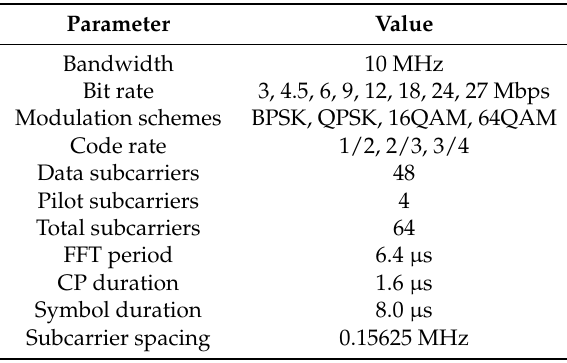
Table 1. IEEE 802.11p system